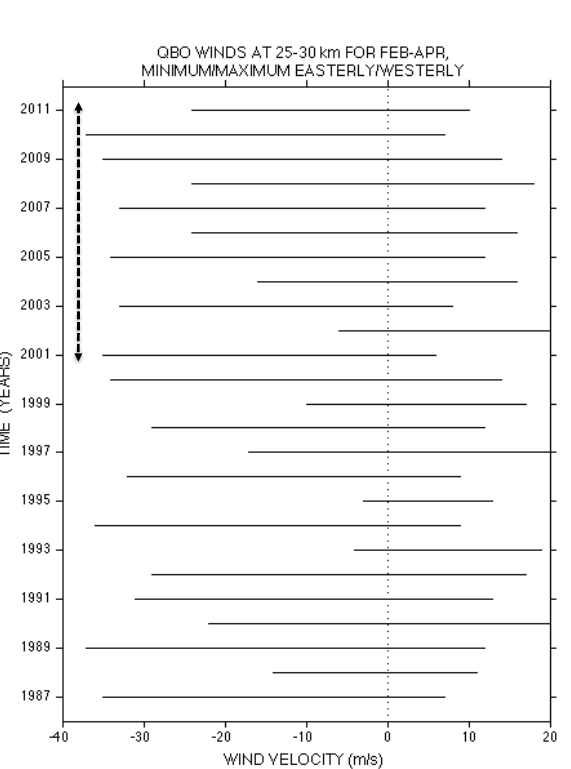
Fig. 7. Comparison of monthly zonal low-passed (60-day cut-off) radar winds over Ascension Island at 84km (solid line) with the strongest eastward (short-dashed) and westward (long-dashed) QBO wind data at 25–30km for February to April from 2001 to 2011. The double- headed arrow shows the small difference between the easterly and westerly maximum winds. The circles identify the westward phase of the MSAO.